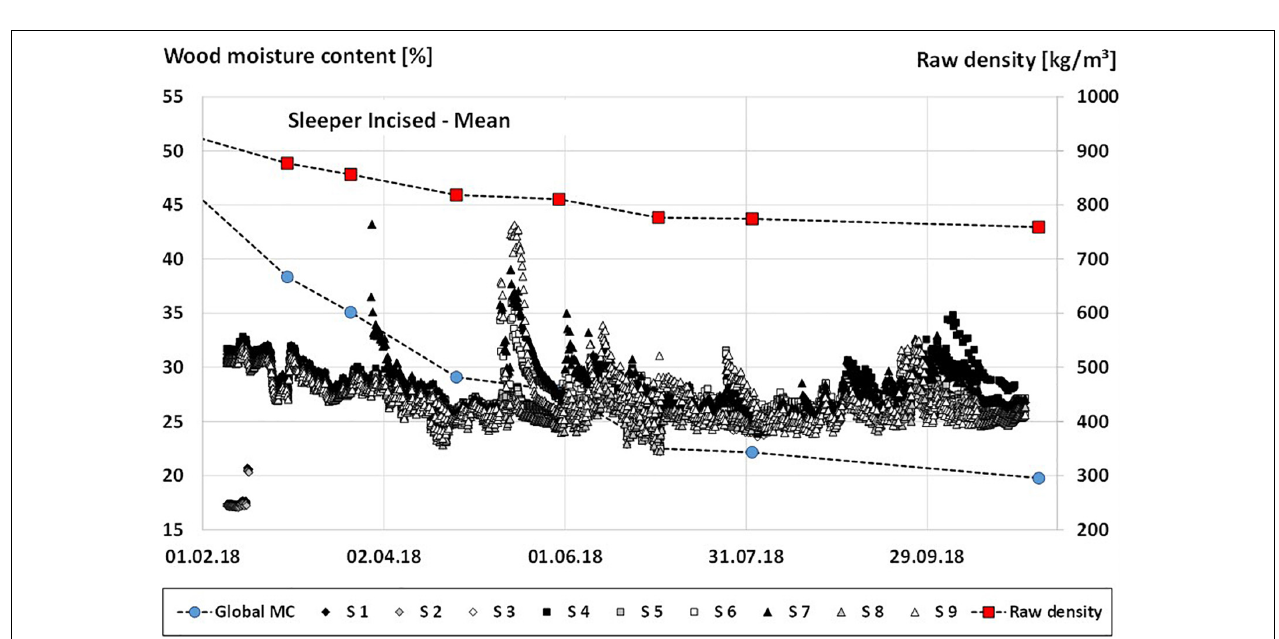
FIGURE 4 | Electrically determined mean local moisture content (MC) at measuring points S1 to S9, mean gravimetrically determined global MC, and mean raw density of sleepers with incising during seasoning.